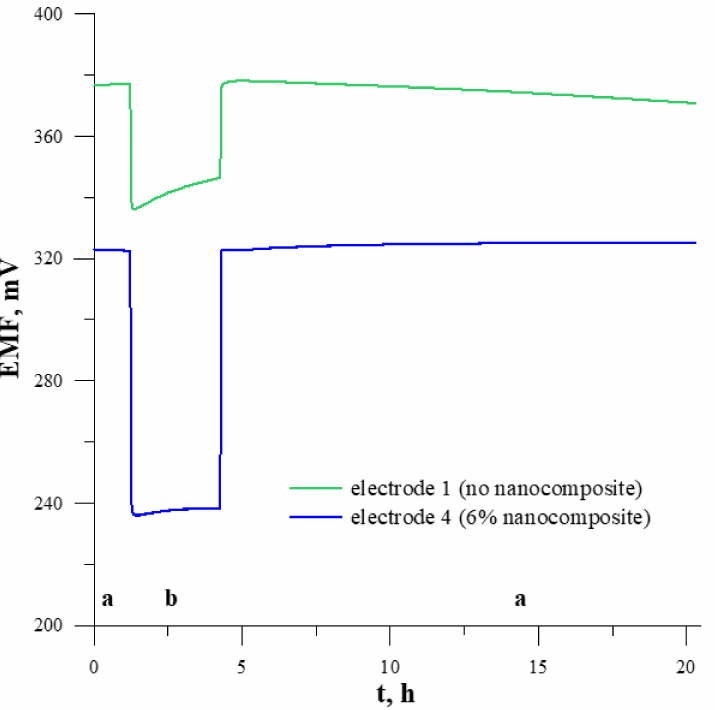
Figure 8. Water layer test of electrode 1 and 4 determined in 1 × 10 − 2 mol L − 1 Cu(NO 3 ) 2 (a) and 1 × 10 − 2 mol L − 1 Zn(NO 3 ) 2